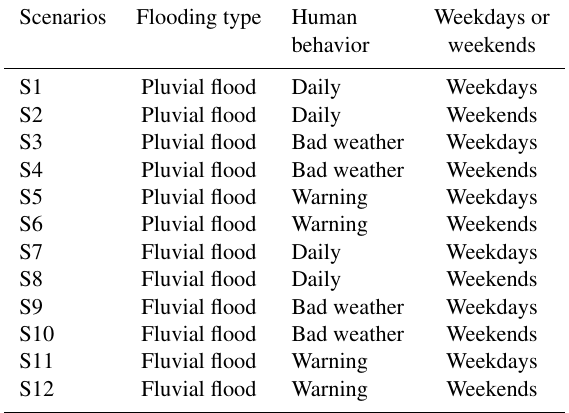
Table 3. Parameter variations used in the simulation scenarios.